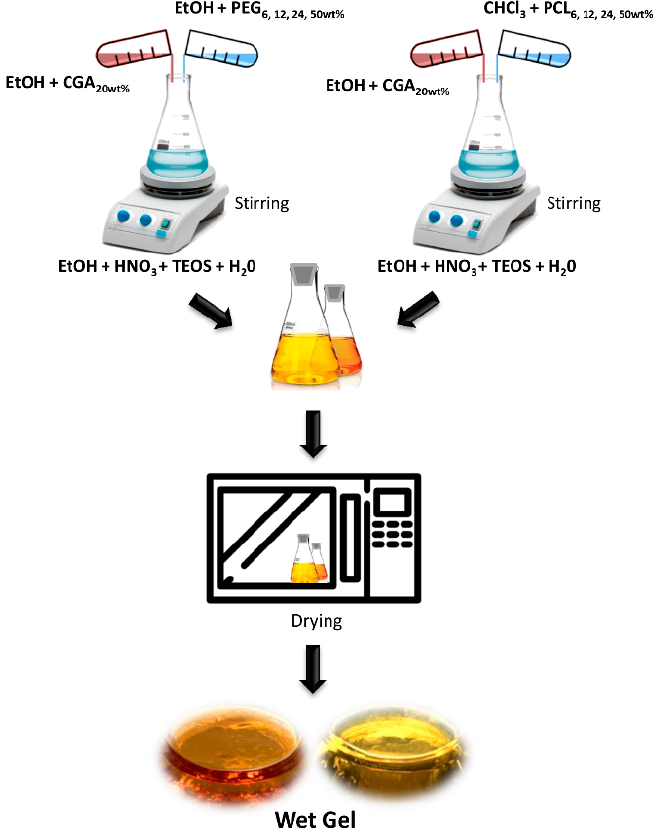
Figure 1. Flow chart of sol–gel synthesis.